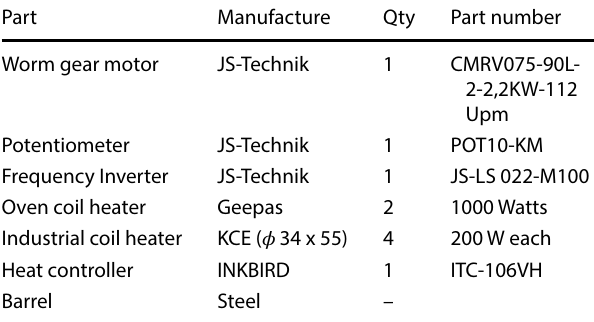
Table 5 Extruder components list Table 6 Mechanical specifications of the plastic recycling machine